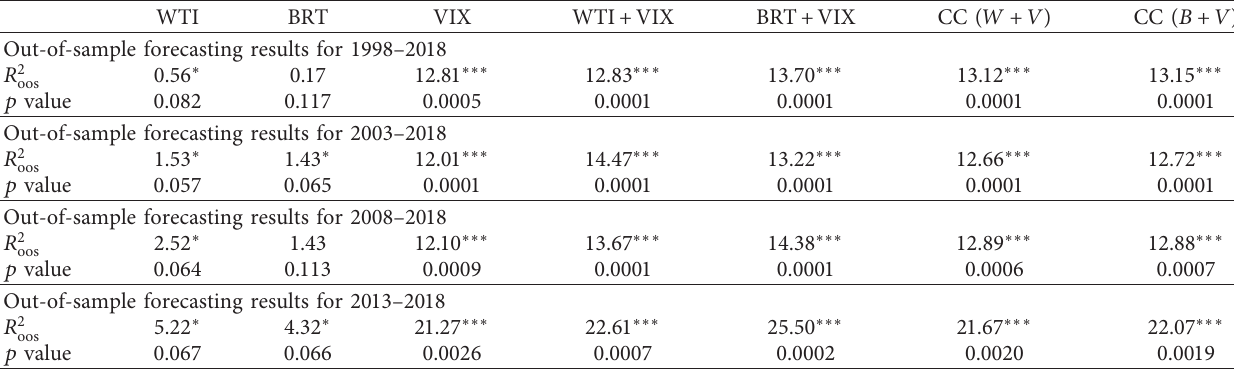
Table 4: Out-of-sample forecasting results, rolling window.